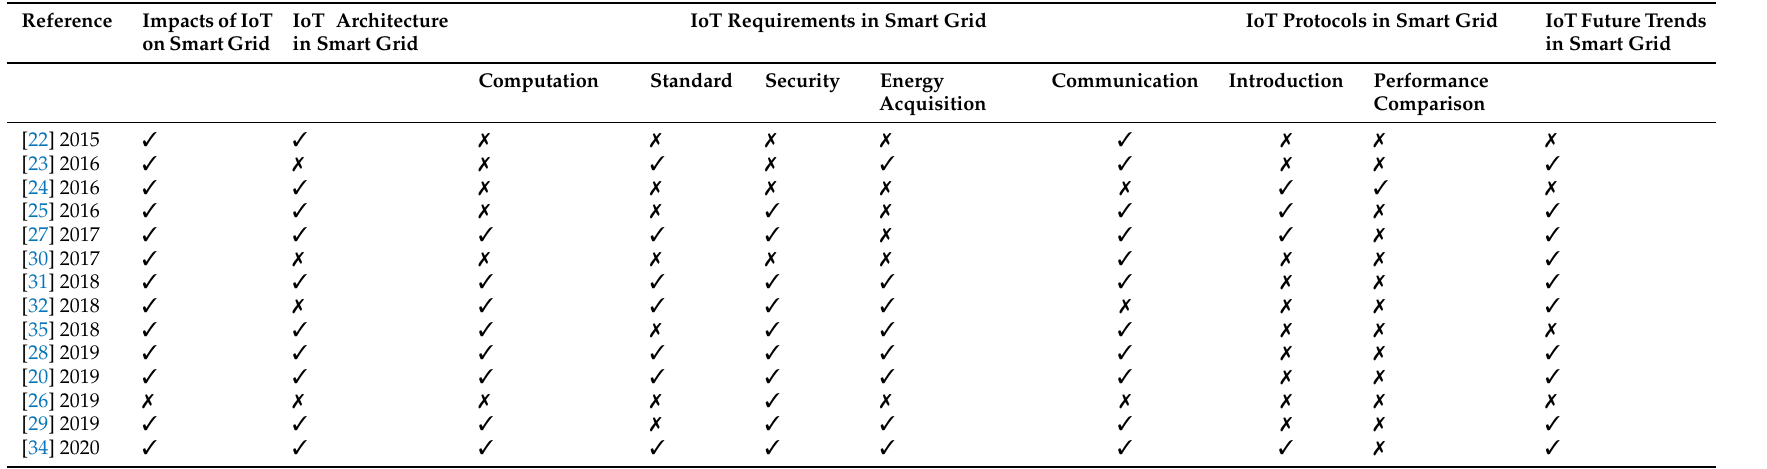
Table 1. Related works objectives’